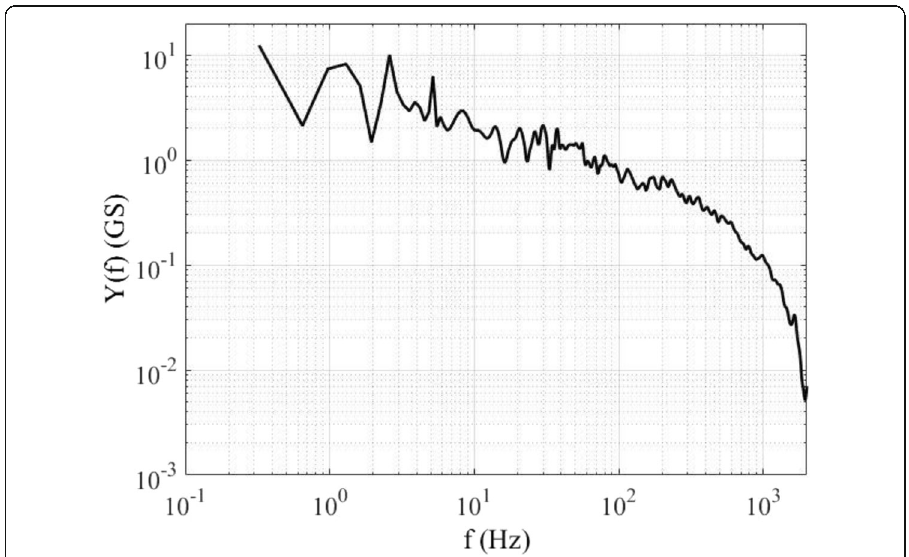
Fig. 7 Ensemble-averaged grayscale spectral energy distribution with respect to frequency, determined from Fig. 6 data, for pixel locations near the shock wave from data acquired on 13 November